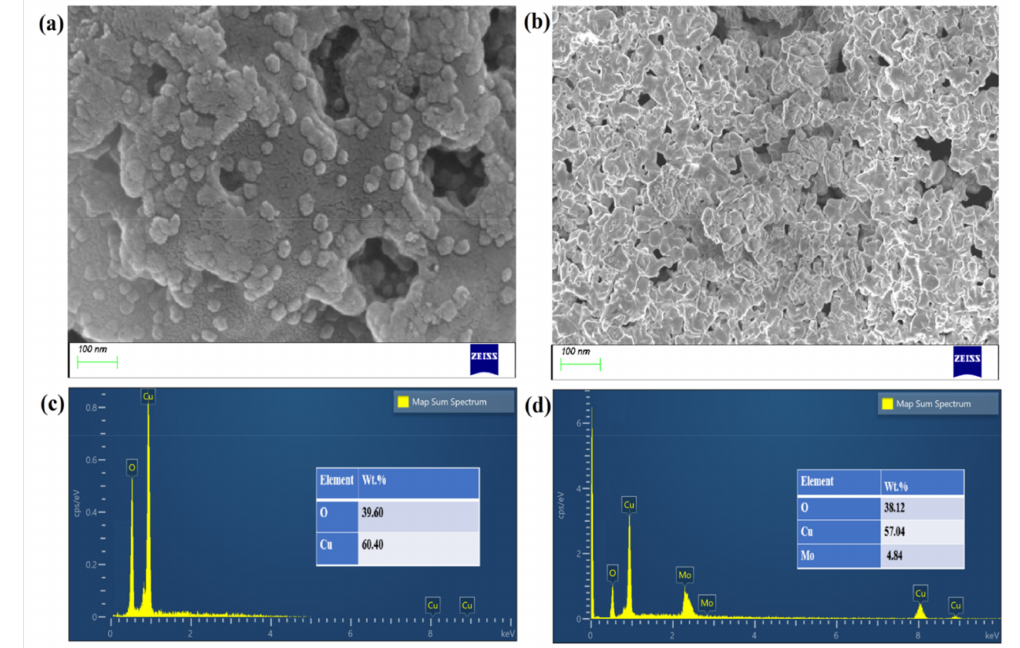
Figure 2. SEM images of ( a ) pure CuO ( b ) MoCu-4 samples, EDX of ( c ) pure CuO and ( d ) MoCu-4 sample.